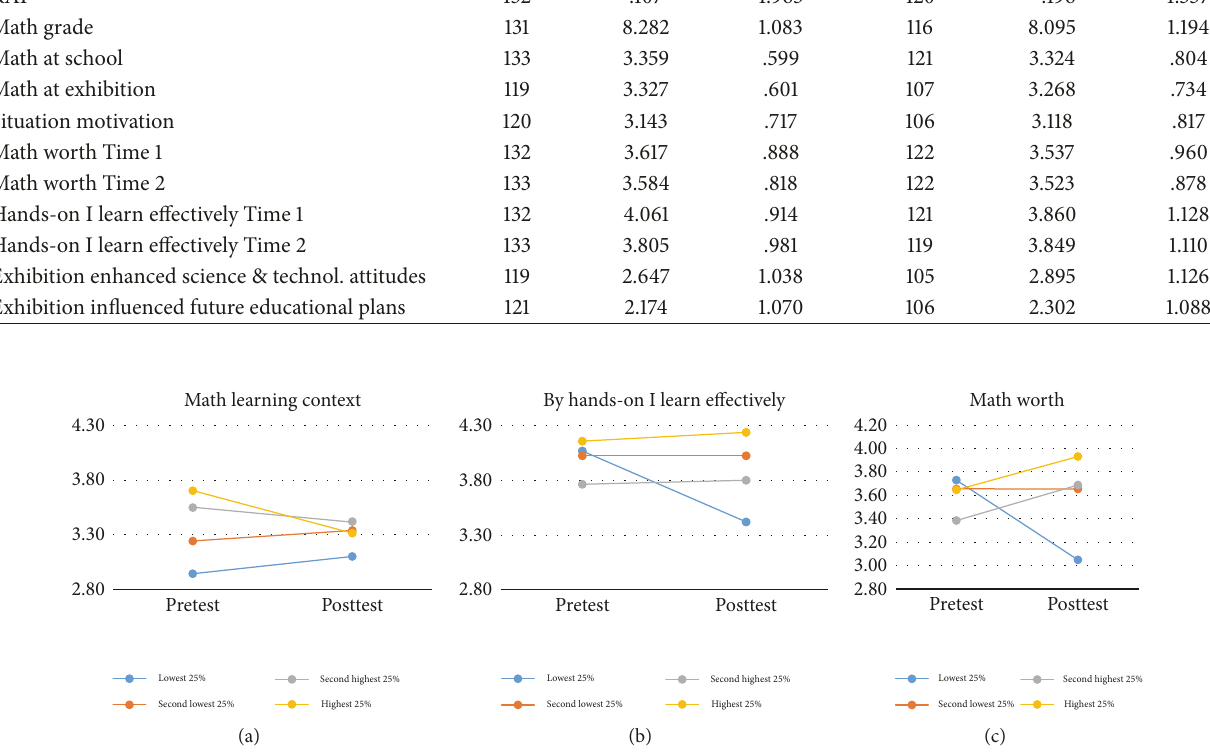
Figure 1: Liking of math learning in the school context and in the exhibition context (a); by hands-on I learn effectively T1 and T2 (b); and math worth T1 and T2 (c) by math achievement